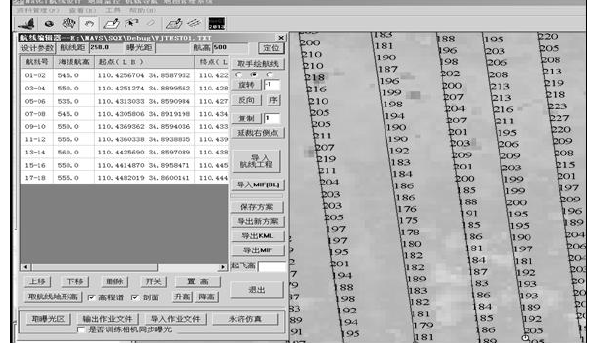
Figure 1. Airline created by Nav GT based on countrywide